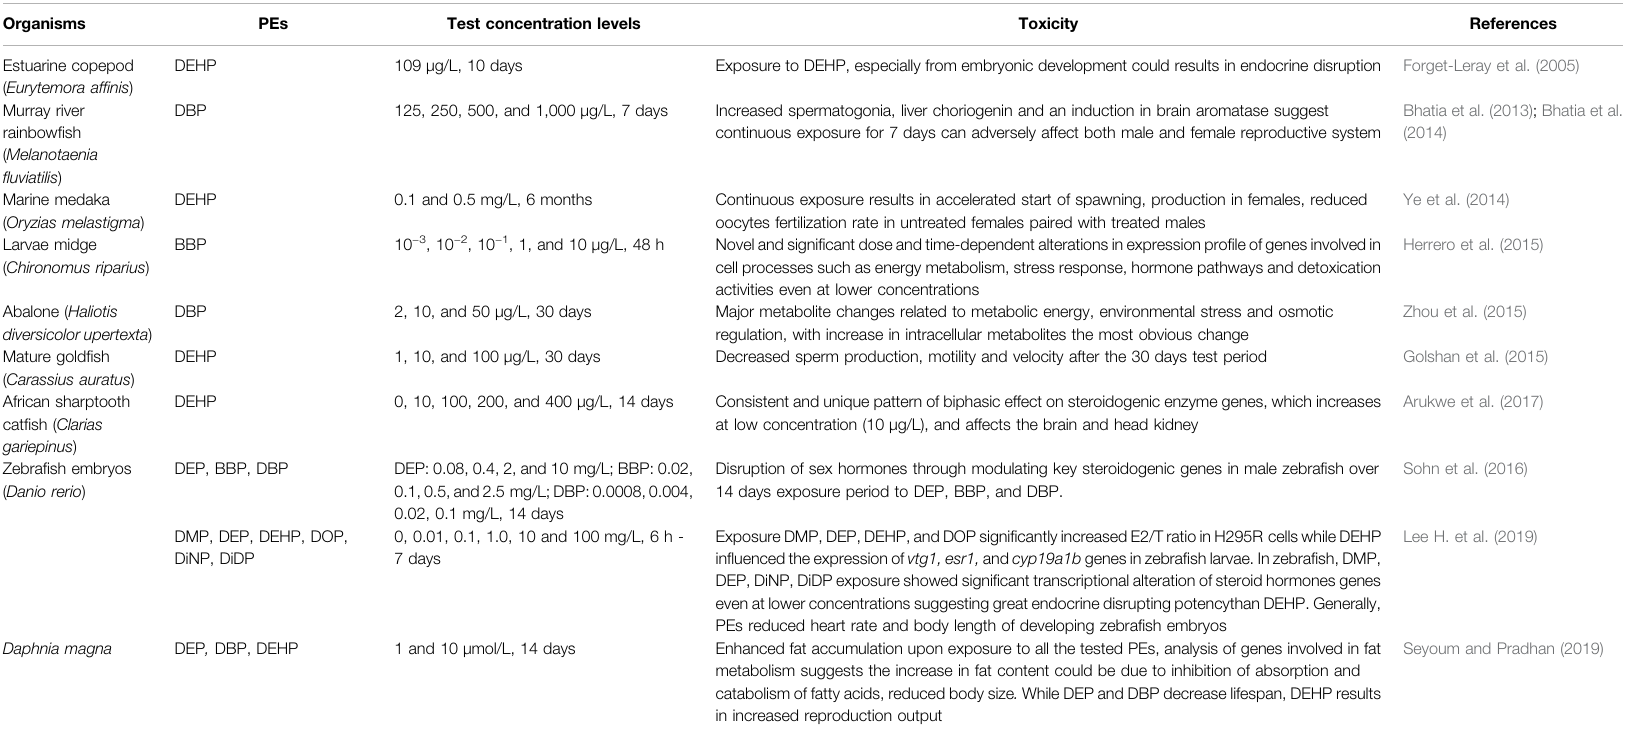
TABLE 4 | Toxic effects of some PEs on aquatic